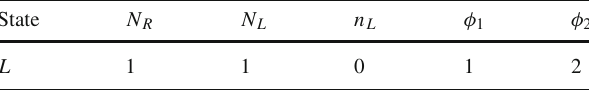
Table1 NewfermionsandscalarswiththeirchargeunderLeptonnum- ber. φ 1 , 2 are SM singlet scalars while N R is right-handed and N L and n L are left-handed SM singlet